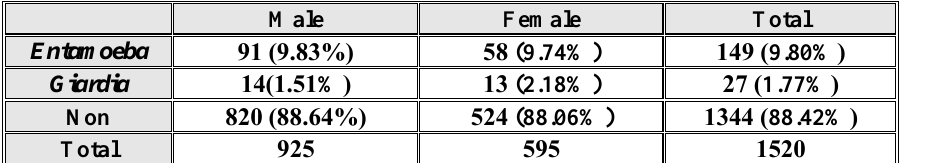
Table (1): Distribution of Entamoeba histolytica and Giardia lamblia according to the gender from the period between September – December